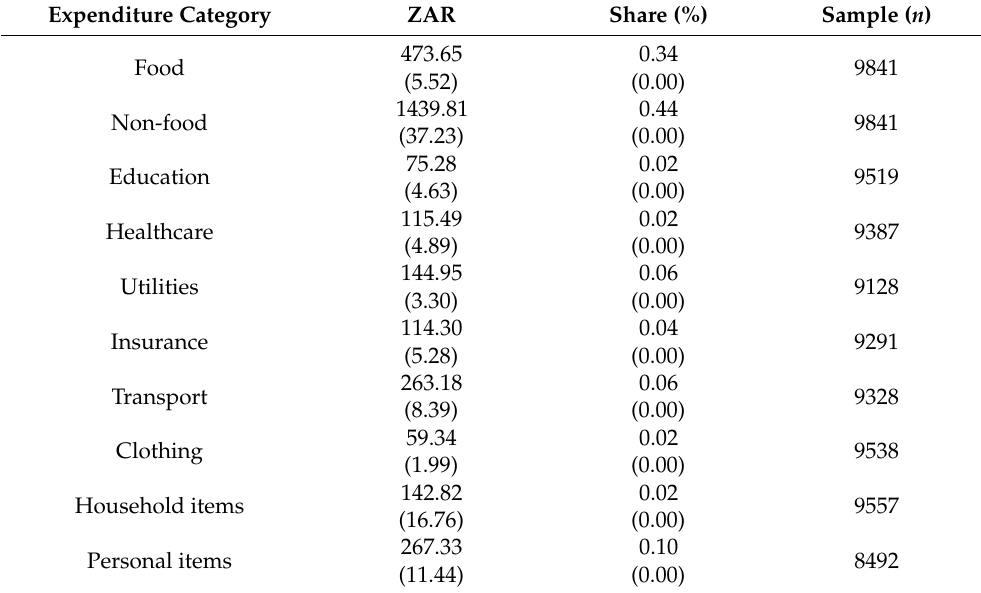
Table 3. Monthly per capita household expenditure and expenditure